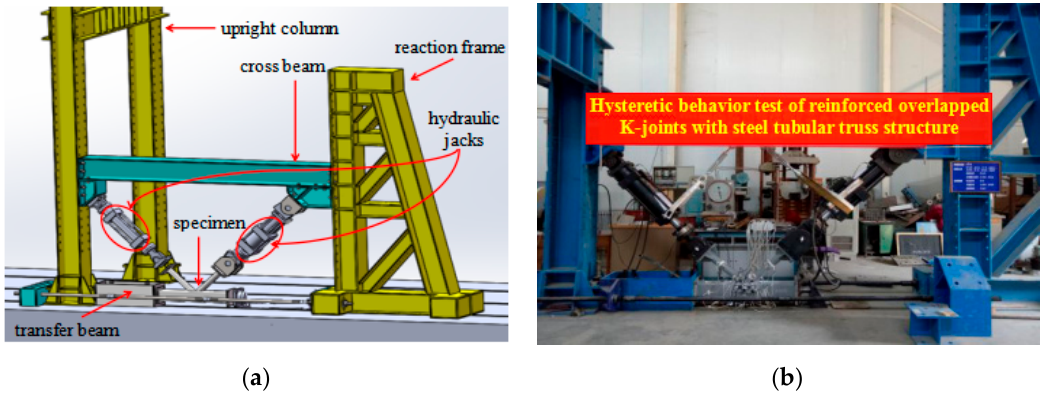
Figure 3. Loading device. ( a ) Design drawing of test loading device; ( b ) The test site.